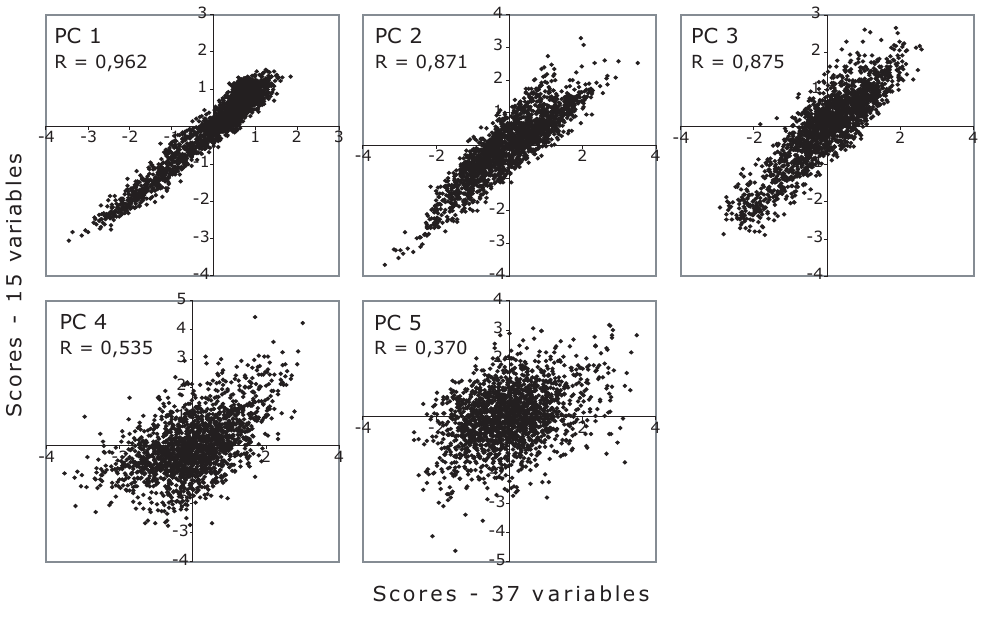
Fig. 5. Score correlations ( n = 1958) between the original variable set of 37 variables and the reduced set of 15 variables for the first five